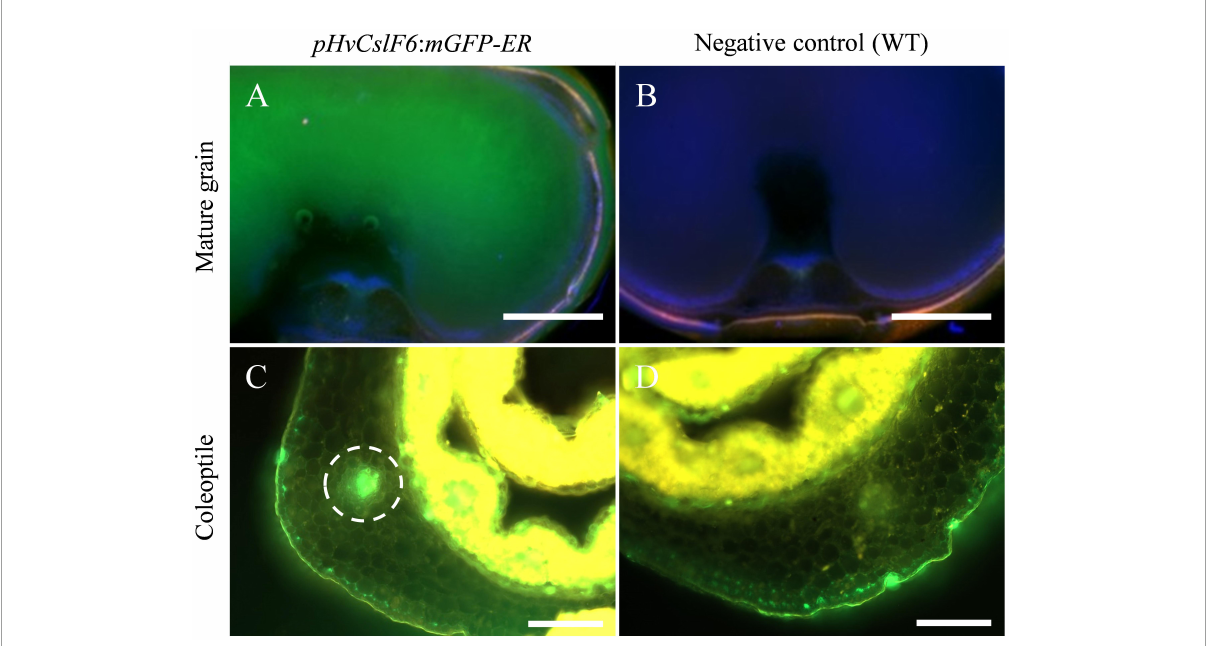
FIGURE1 Fluorescent images of pHvCslF6:mGFP-ER (–3,000 bp) barley transverse sections in mature grain and coleoptile tissues (cv. Golden Promise). (A) Mature grain from line transformed with pHvCslF6:mGFP-ER , (B) negative control of wild type grain section, (C) coleoptile from line transformed with pHvCslF6:mGFP-ER , (D) negative control of wild type coleoptile section. The positive control is mGFP-ER driven by the 35S CaMV promoter. The dashed circle indicates the location of a vascular bundle. Images were collected on a Zeiss M2 AxioImager equipped with DIC optics and an Apotome.2 (Zeiss, Germany). GFP was excited at 488 nm and emission collected from 499 to 530 nm, in green. Scale bars are 1 mm.